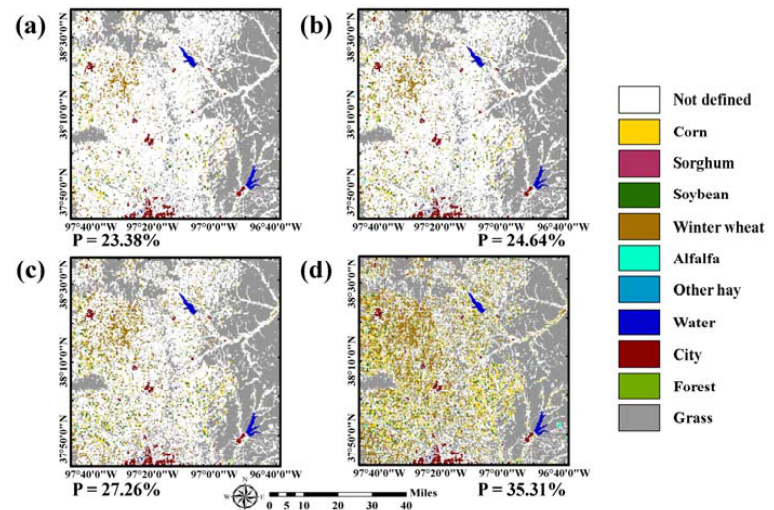
Figure 4. Rule-based class label images predicted from past CDLs: ( a ) 5-year (2010 to 2014), ( b ) 4-year (2011 to 2014), ( c ) 3-year (2012 to 2014), and ( d ) 2-year (2013 to 2014). P (the percentage value below each predicted class label image) denotes the proportion of pixels in which the class label for 2015 could be predicted.